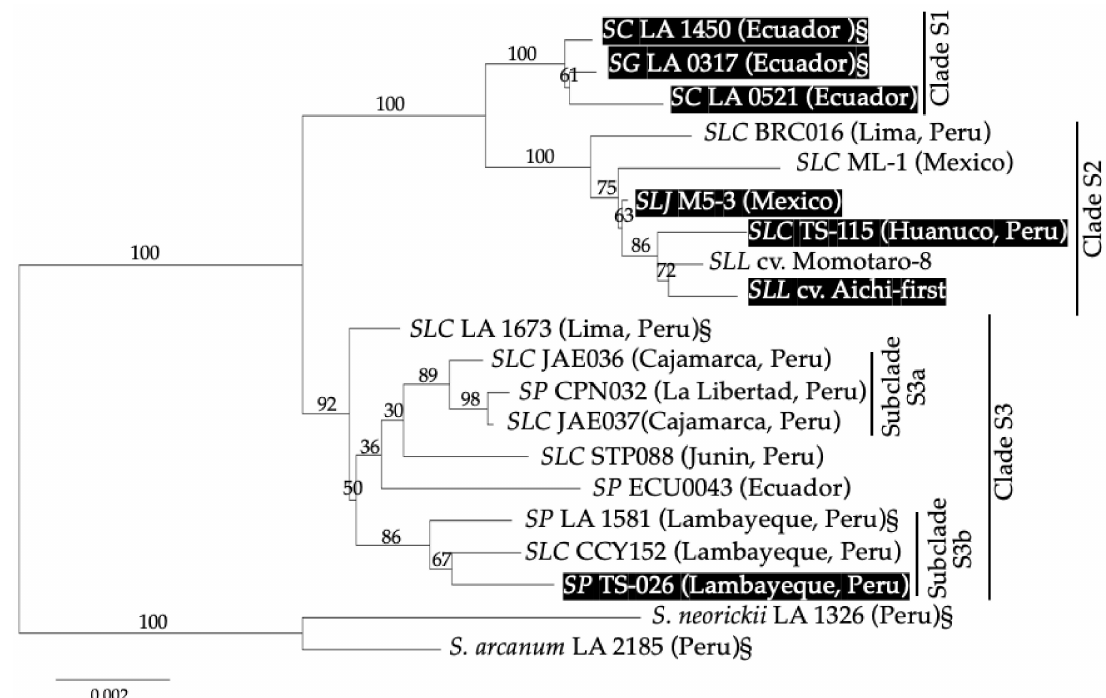
Figure 6. A maximum likelihood (ML) tree based on 18 COSII sequences of tomato accessions estimated using Modeltest-NG ver. 0. 1. 6 [26] and RAxML-NG v. 1.0.0 [27]. S. arcanum and S. neorickii were used as outgroups. The bootstrap values were calculated after 1,000 bootstrap replicates. The data sets of SG (LA 0317), SC (LA 1450), SLC (LA 1673), SP LA 1581), S. arcanum (LA 2185) and S. neorickii (LA 1326) are from [10] and are indicated with a § symbol in the tree. AAL-toxin susceptible accessions are highlighted with a black background. SC , S. cheesmaniae ; SG , S. galapagense ; SLC , S. lycopersicum var. cerasiforme ; SLJ , S. lycopersicum var. lycopersicum “jitomate criollo”, SLL , S. lycopersicum var. lycopersicum (commercial varieties); SP , S. pimpinellifolium